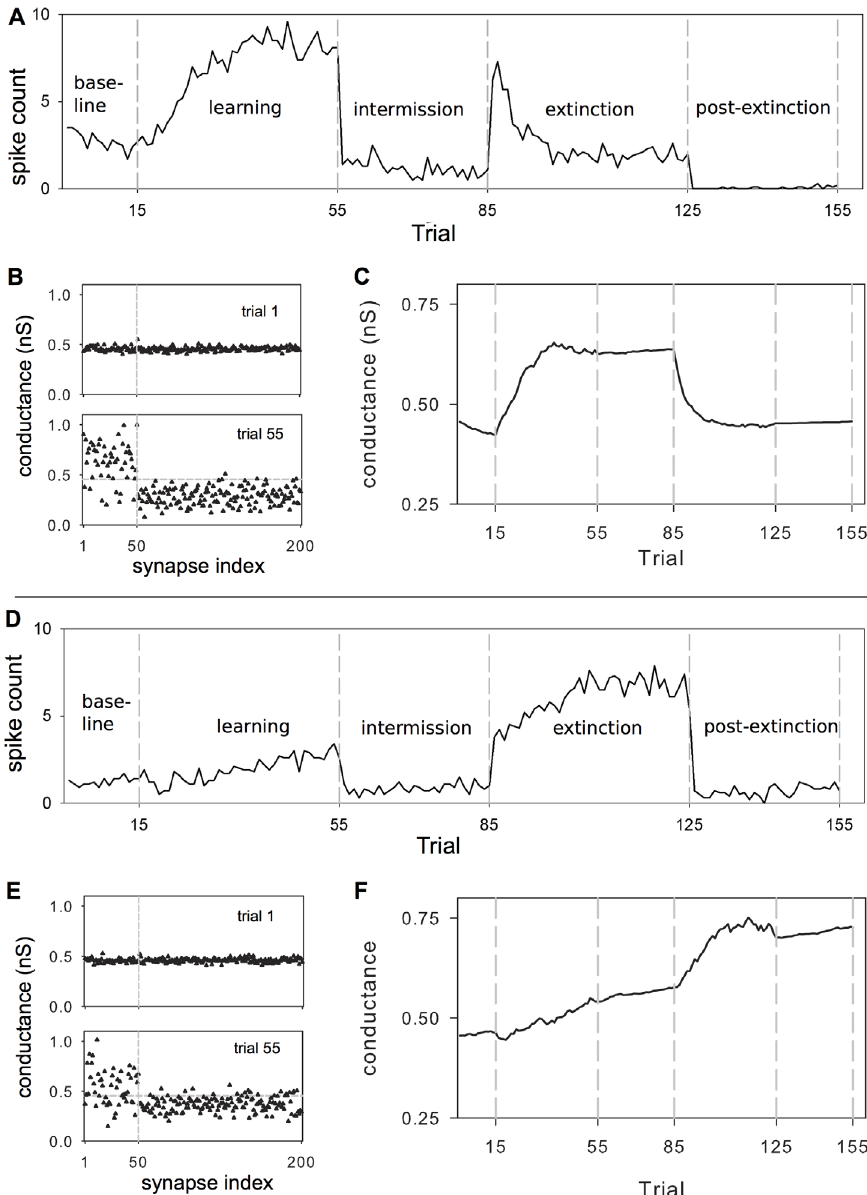
Figure 7. Behaviour of MSNs obtained with the STDE plasticity rules (we plot here means obtained over ten experiments with different random initialisation of AMPA conductances). (A) and (D) are the response profiles, for D1-MSNs and D2-MSNs, repectively, plotted as spike count per trial against trial number; key trials delimit epochs defined in Figure 1. Coefficients for D1-MSNs were: ~ 1 : 3, k { ~ 0, k z ~{ 0 : 4, k { ~{ 0 : 5 ; and for D2-MSNs were: k z ~ 0 : 35, k { ~{ 0 : 85, k z ~ 0 : 3, k { ~ 0 : 3 . (B) and (E) the mean AMPA k z lo lo hi hi lo lo hi hi conductances for D1-, D2-MSNs of each synapse at trials 1 and 55. Synapses in the set, S , (50 synapses consistently subject to stronger input during the learning and extinction epochs), are collected at the left hand side of each plot, and delimited by the vertical dotted line. The horizontal dotted line shows the initial mean AMPA conductance of 0.458 nS. (C) and (F) The mean conductance of the set S against trial number (D1-, D2-MSNs,